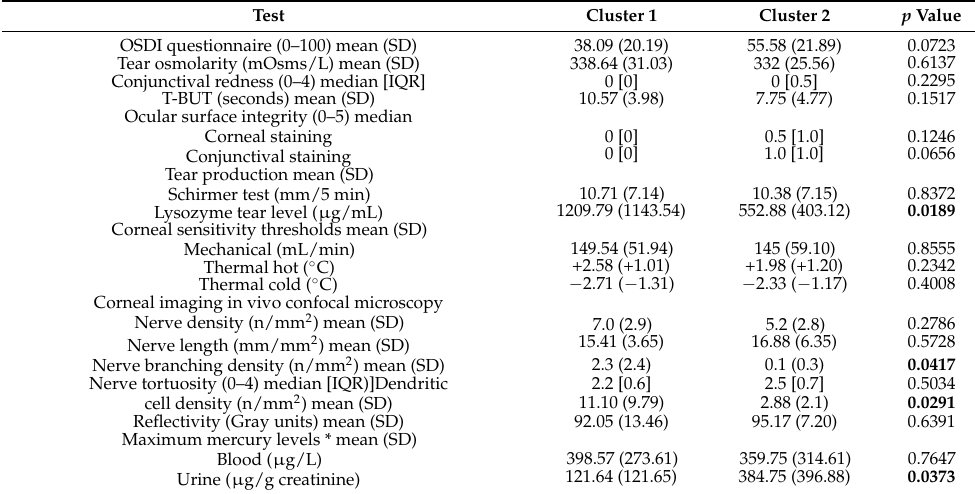
OSDI = Ocular Surface Disease Index; IQR = Interquartile range. * Mercury normal levels = blood < 10 µ g/L and urine < 30 µ g/g creatinine. * p value corresponding to comparison of concentration values between patient and control groups. Significant p values ( p < 0.05) are denoted in